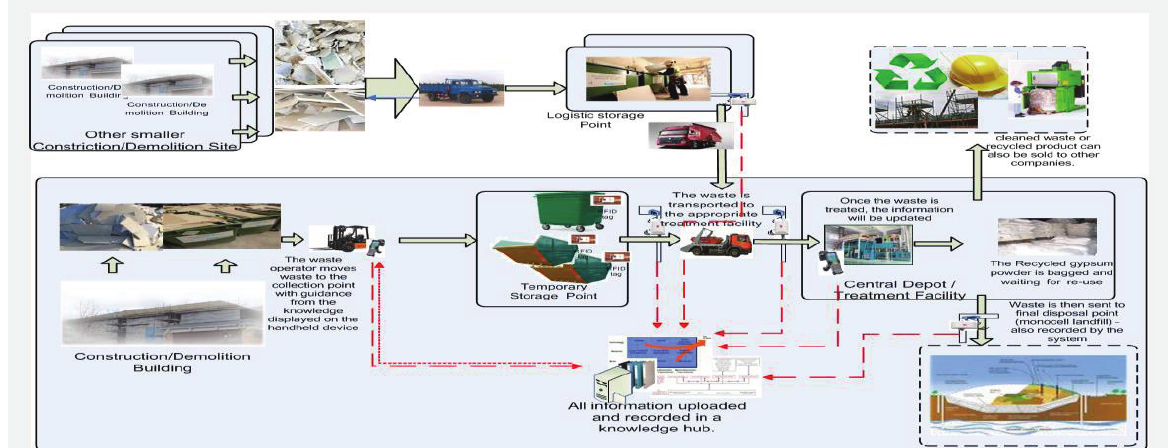
Fig. 4. Proposed System for Plasterboard Waste Management using RFID Technology and Knowledge Hub for Tracking and Verification Purposes